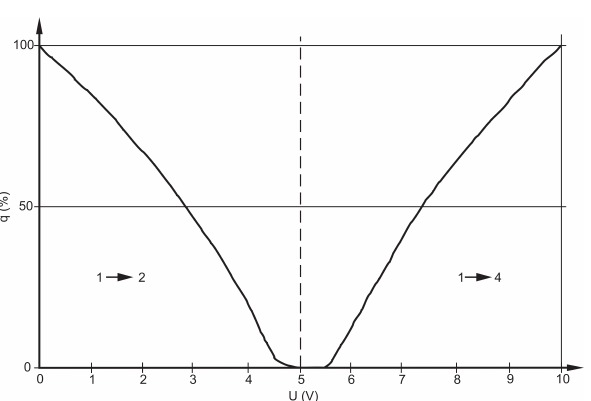
Figure 4: Flow characteristics of MPYE valve.